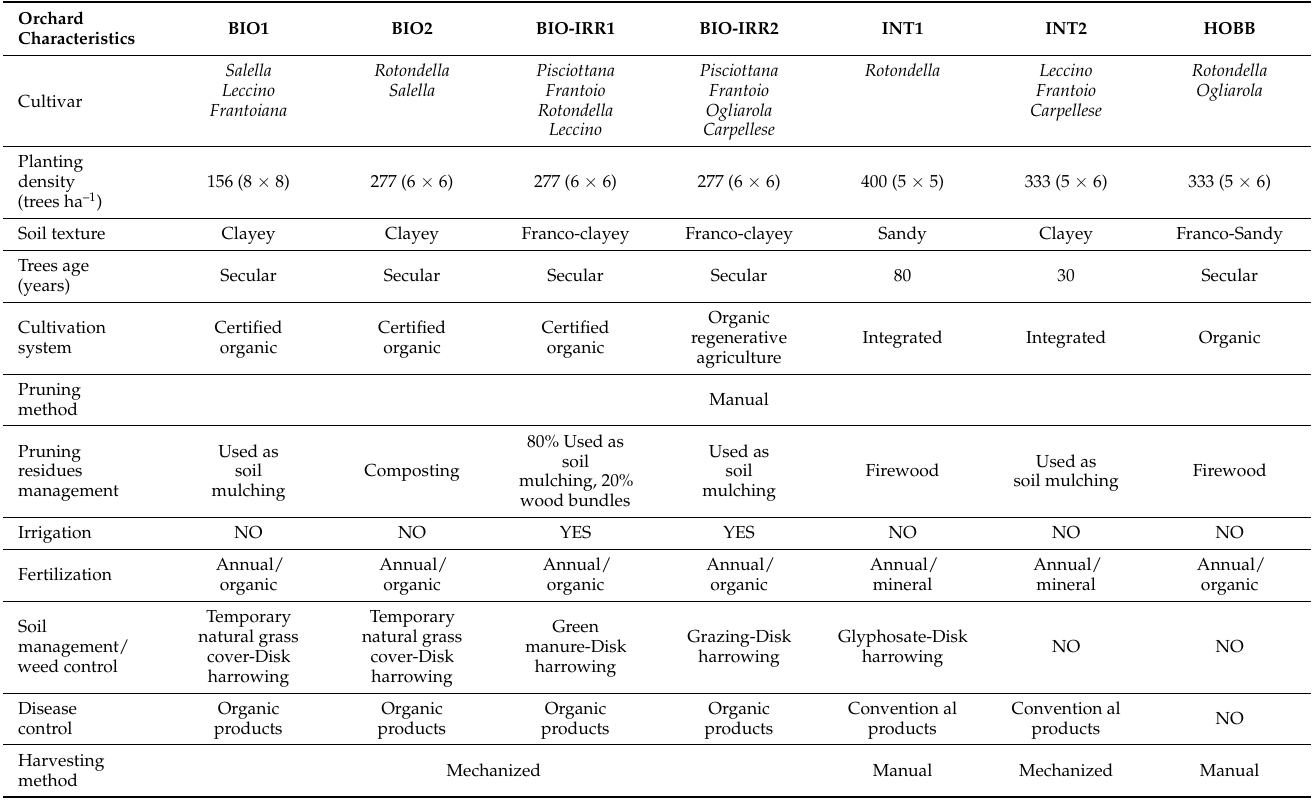
Table 1. Technical and agronomic characteristics of the analyzed